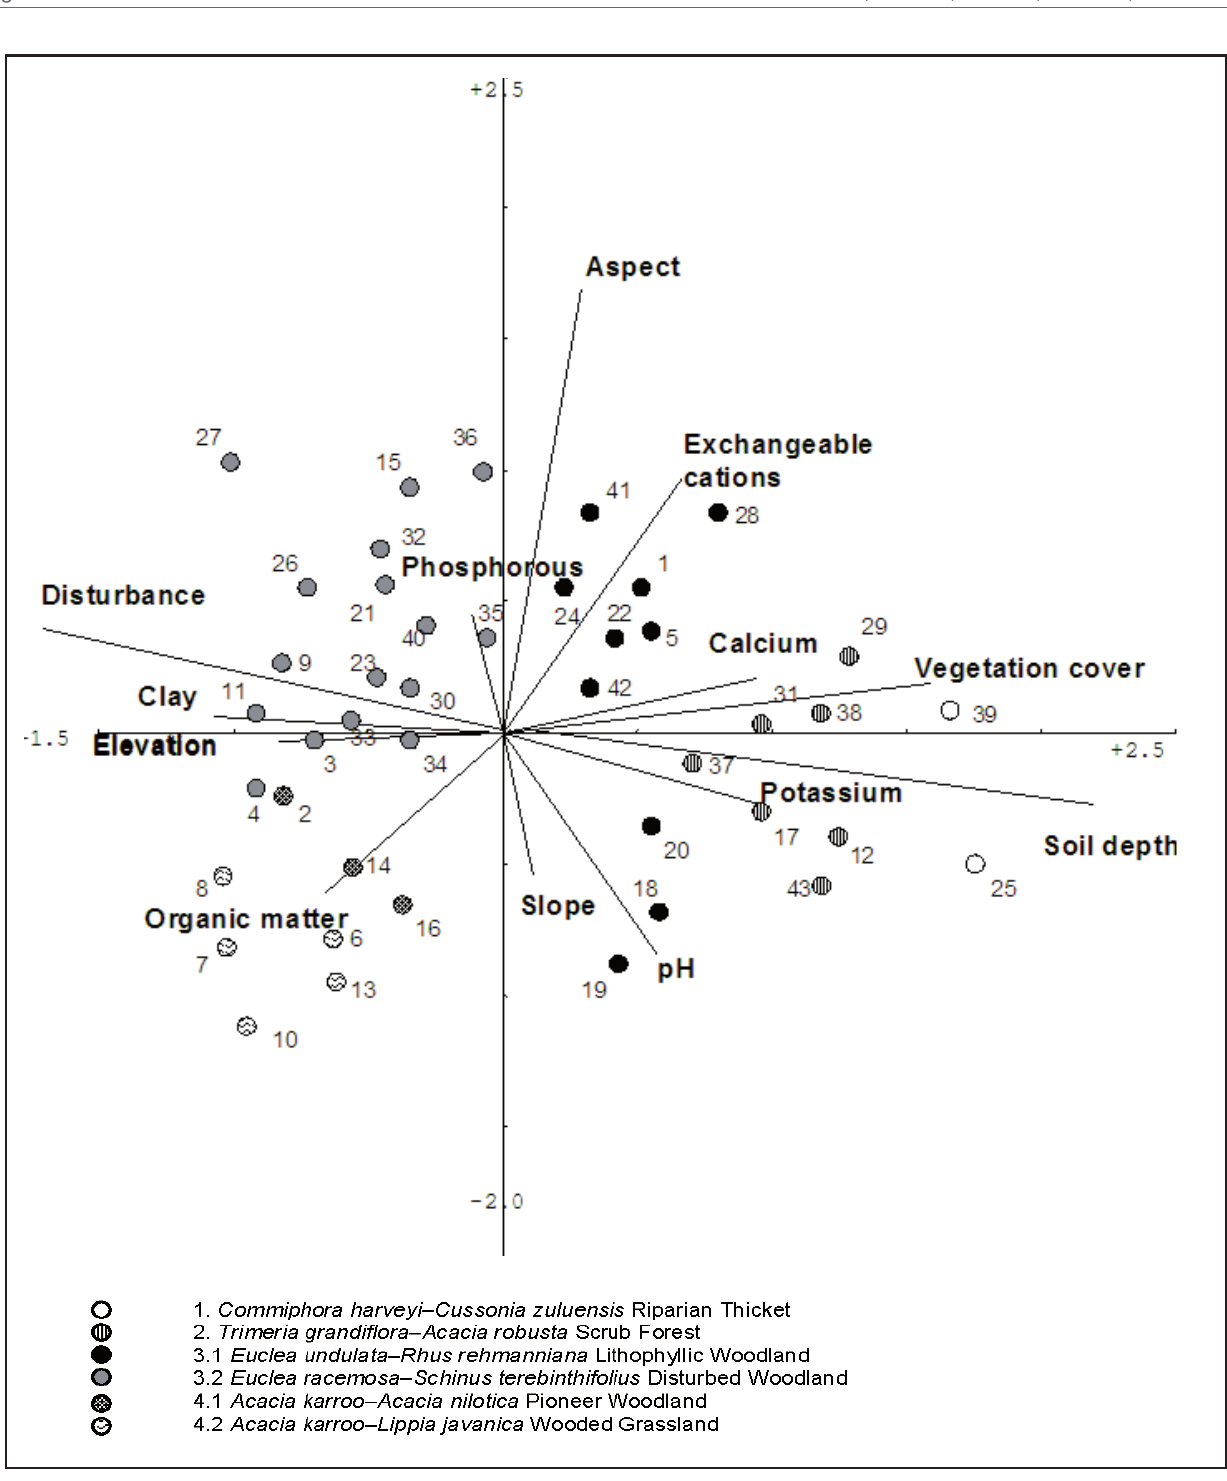
Figure 8 First axis of a CCA showing a gradient from lower-lying, relatively undisturbed, steeper areas with relatively deeper soils near drainage lines and a higher canopy cover to higher-lying, relatively flat areas with shallower soils and higher disturbance regimes. Axis one: woody species data; axis two: sites and aspect, elevation, slope, vegetation cover, disturbance, soil depth, and soil factors: calcium, phosphorus and potassium content, clay and organic-matter percentage, exchangeable cations and pH better indicated in a two-dimensional plot of the axes of a CCA. Soil depth and disturbance are the most important variables on axis 1, whereas aspect is the most important factor on axis 2 (Fig. 8). The first axis of a CCA (Fig. 8) corresponds with the CA (Fig. 7), namely a gradient from relatively undisturbed, low- lying areas with relatively deeper, less clayey soils near drainage lines and higher densities of broadleaf species to higher-lying areas with relatively shallower, clay soils that vary from 100 to 250 mm in depth and that were previously disturbed (Table